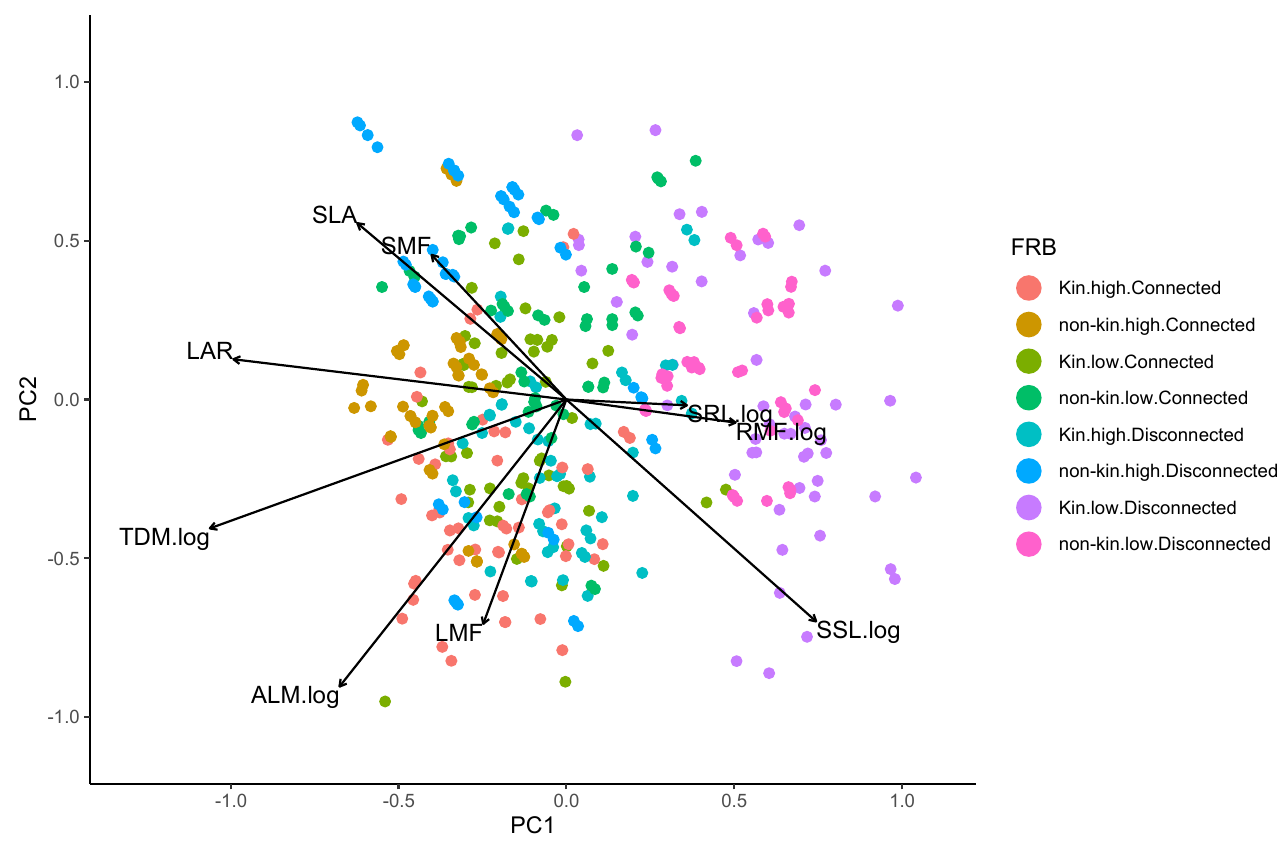
Figure 5. Principal components analysis of the individual × trait value data. The first and second principal components account for 24.5% and 18.4% of the total inertia respectively. Colours indicate treatment combinations for individual plants in the experiment. The trait distributions indicate that the first axis represents a trade-off between allocation to roots on the right versus allocation to light capturing surface and total biomass accumulation on the left. Trait spread along the second axis suggests a tradeoff between total allocation to leaves on the bottom and allocation to stems on the top.